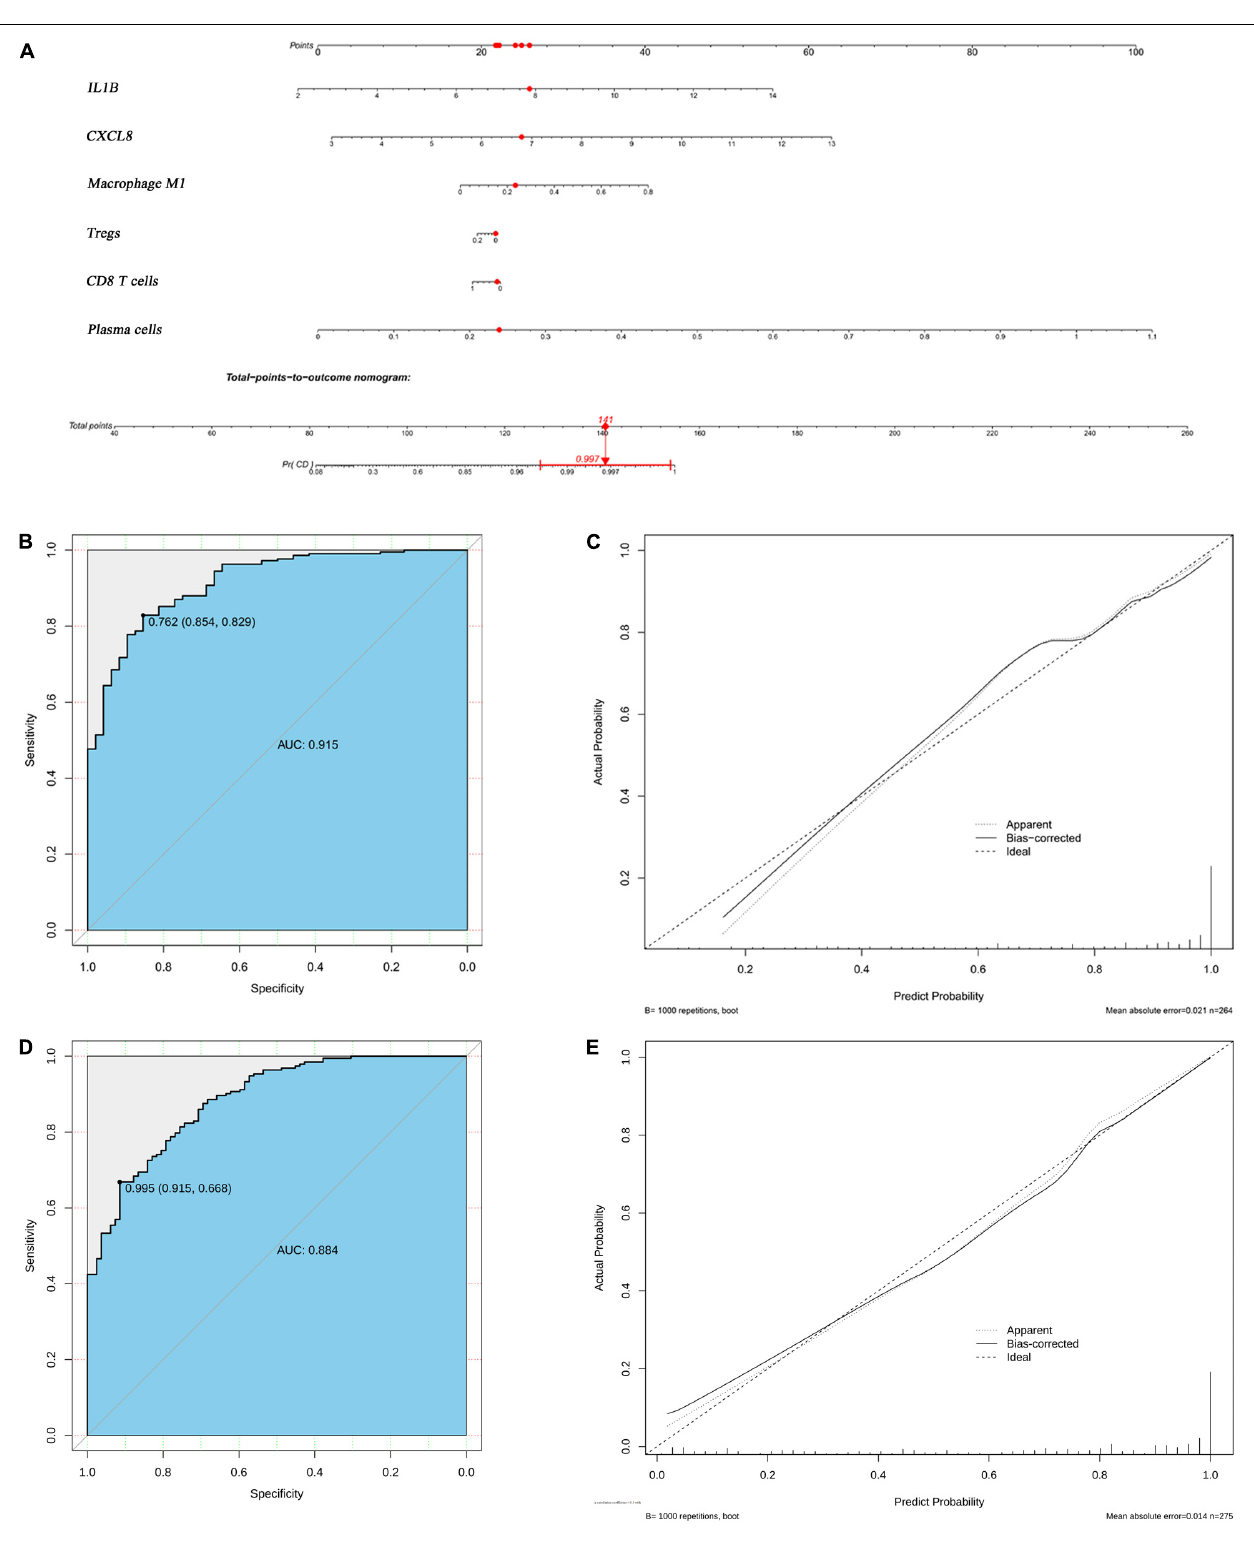
FIGURE 8 | Logistic regression analyses of both the derivation and validation cohorts. (A) Nomogram predicting CD probability. (B) ROC curve and (C) calibration curve of the model from derivation cohort. (D) ROC curve and (E) the calibration curve of the model from validation cohort.